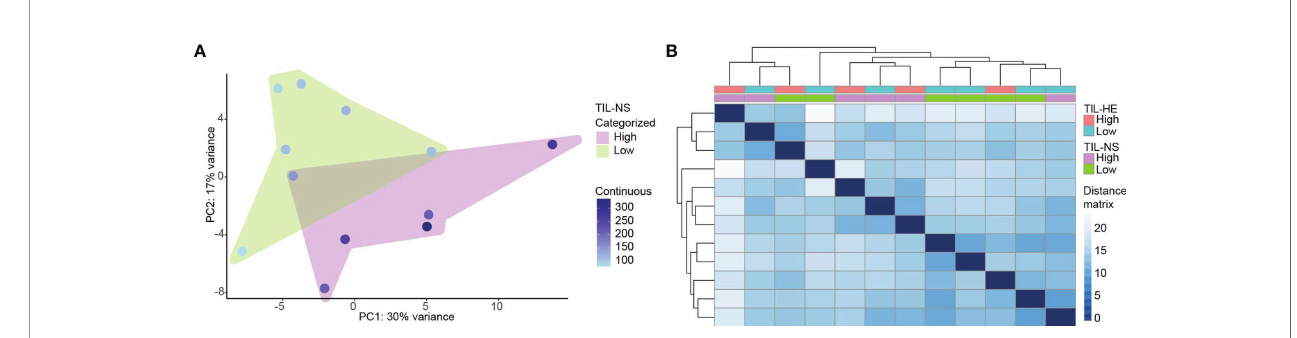
FIGURE 4 | Specimens with a low and high TIL-NS show overlapping gene expression. (A) Principal component analysis of samples clustered on low and high TIL-NS. The color of the dots represents the TIL-NS score. (B) Distance matrix of samples with hierarchical clustering. Color bars represent low or high TIL-HE or